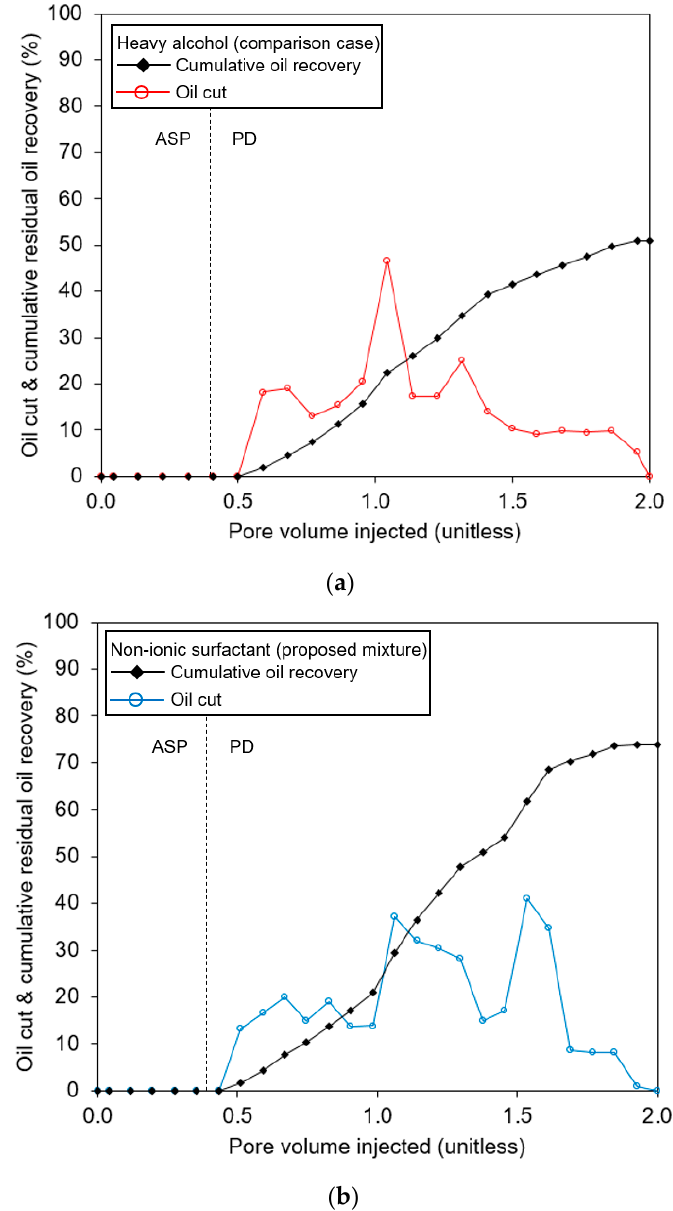
Figure 6. Oilcut and cumulative oil recovery after pre-flush: (a) the reference case (heavy alcohol); (b) the proposed case (the nonionic surfactant) mixing with 0.25 wt% 1:4 (wt/wt) of LAS and DOSS anionic surfactant pair, 0.2 wt% Na 2 CO 3 as the alkali, and 0.15 wt% HPAM as the polymer.